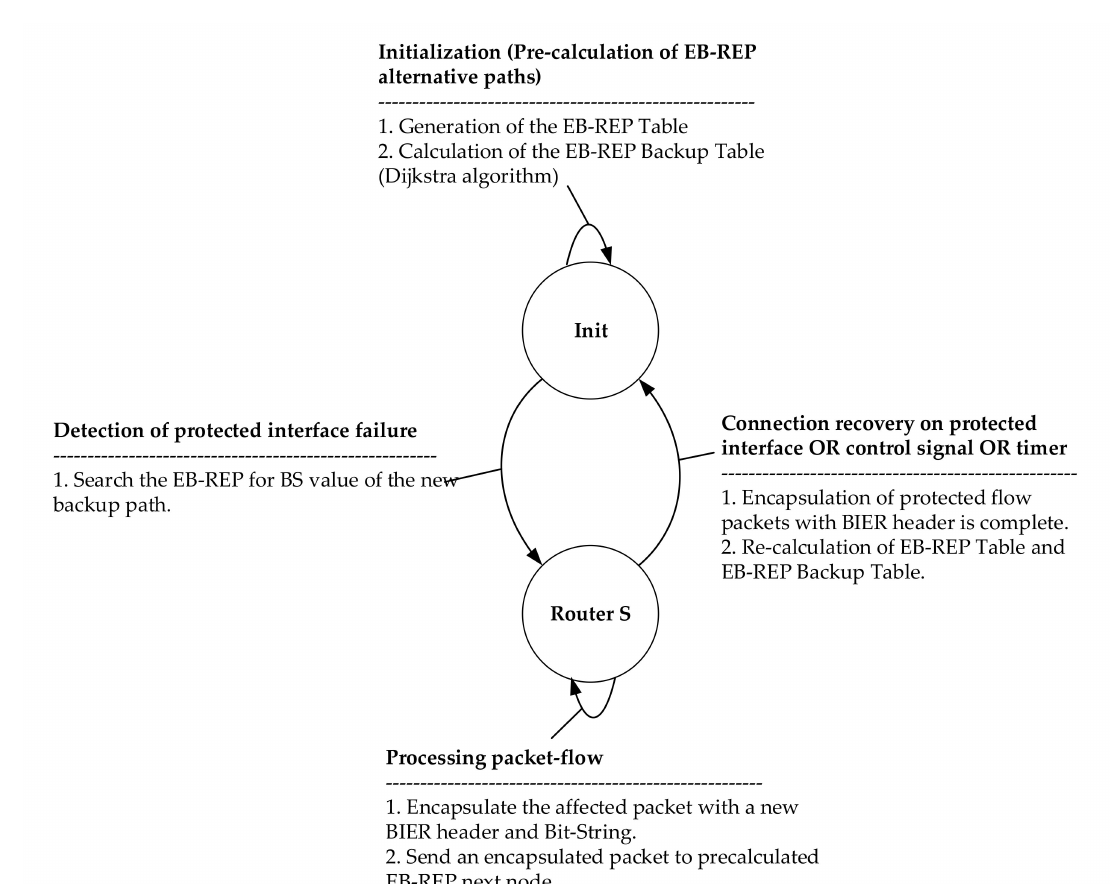
Figure 10. The EB-REP mechanism state diagram of router S.